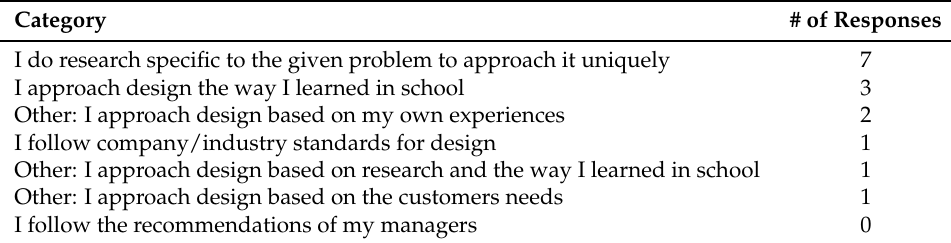
Table 10. Why respondents approach design the way they